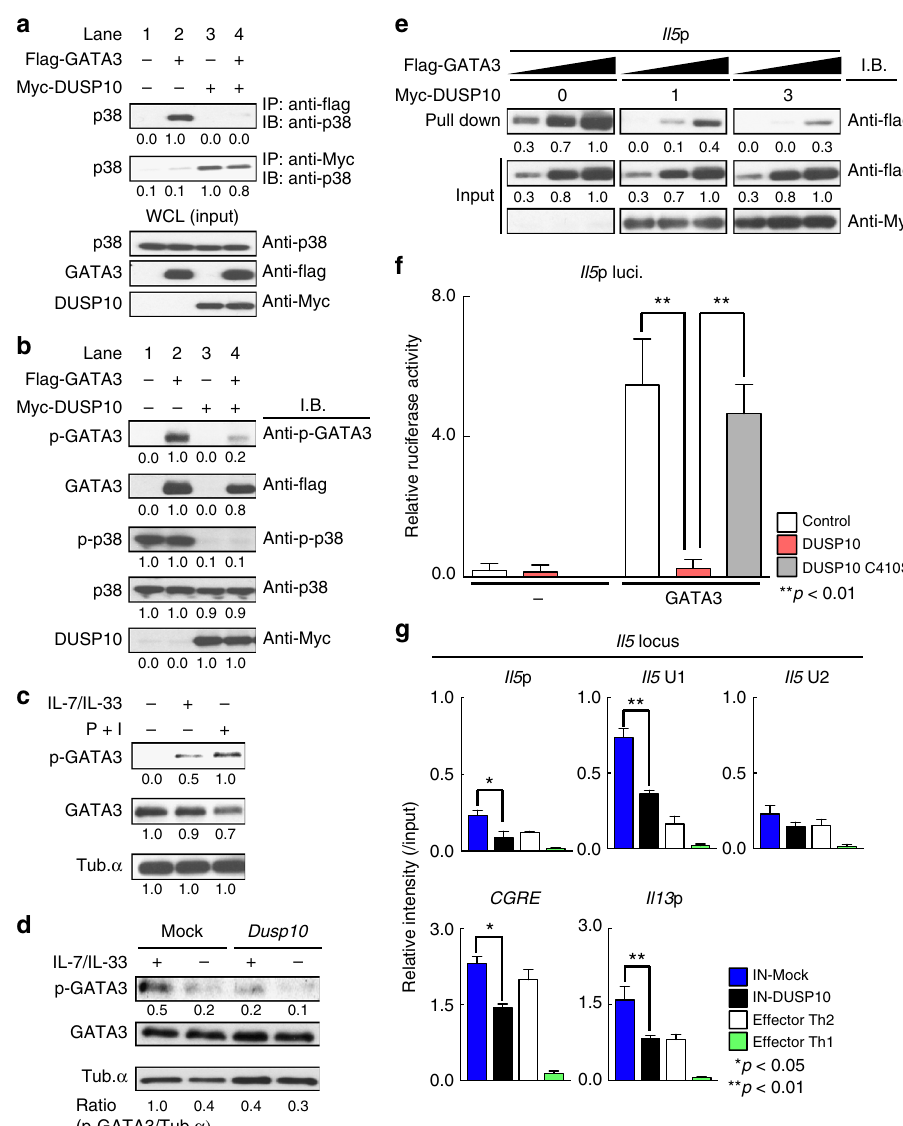
Fig. 5 DUSP10 suppresses the transcriptional activity of GATA3. a , b 293T cells were transfected with Myc-tagged DUSP10 or Flag-tagged GATA3. a Immunoprecipitation assay was performed with anti-Myc or anti-Flag. Immunoblotting of whole-cell lysates is also shown as a control (Input). b The phosphorylated GATA3 (p-GATA3), total GATA3 (GATA3), phosphorylated p38 (p-p38), total p38 (p38) and total DUSP10 (DUSP10) in whole fraction. c The phosphorylated GATA3 (p-GATA3) and total GATA3 (GATA3) in the nuclear fraction from Tpath2 cells. Tpath2 cells were stimulated with P + I, or IL-7 + IL-33 for 30 min. d The phosphorylated GATA3 (p-GATA3) and total GATA3 (GATA3) in the nuclear fraction from Dusp10 -overexpressing ILC2s shown in Fig. 4b. ILC2s were stimulated with IL-7 + IL-33 for 30 min. The arbitrary ratio of the intensity of p-GATA3 to that of tubulin was shown. e 293 T cells were transfected with Myc-tagged DUSP10 or Flag-tagged GATA3, and total extracts were subjected to a pull-down assay using Il5 promoter oligonucleotide as described in the Supplementary information. Immunoblotting of total cell lysates is also shown (Input). The x- axis of GATA3 refers to the amounts of cell lysates (3-fold doses; DNA-precipitants and input samples) that were blotted with anti-Flag Ab. Band intensities were measured with a densitometer and arbitrary densitometric units are shown ( a – e ). f Reporter assays with the Il5 promoter were performed using the Dusp10 -transfected D10. G4.1 Th2 cell line. The mean values with standard deviations of relative luciferase activity of three different experiments are shown. g A ChIP assay was performed with anti-GATA3 at the Il5 gene locus, CGRE and Il13 p in Control- or Dusp10 -overexpressing ILC2s as shown in Fig. 4b, and effector Th1 cells and effector Th2 cells. a – g Three independent experiments were performed with similar results (** p < 0.01; * p < 0.05; Mann – Whitney U test; f , g ). Three technical replicates were performed for reporter ( f ) and ChIP ( g )